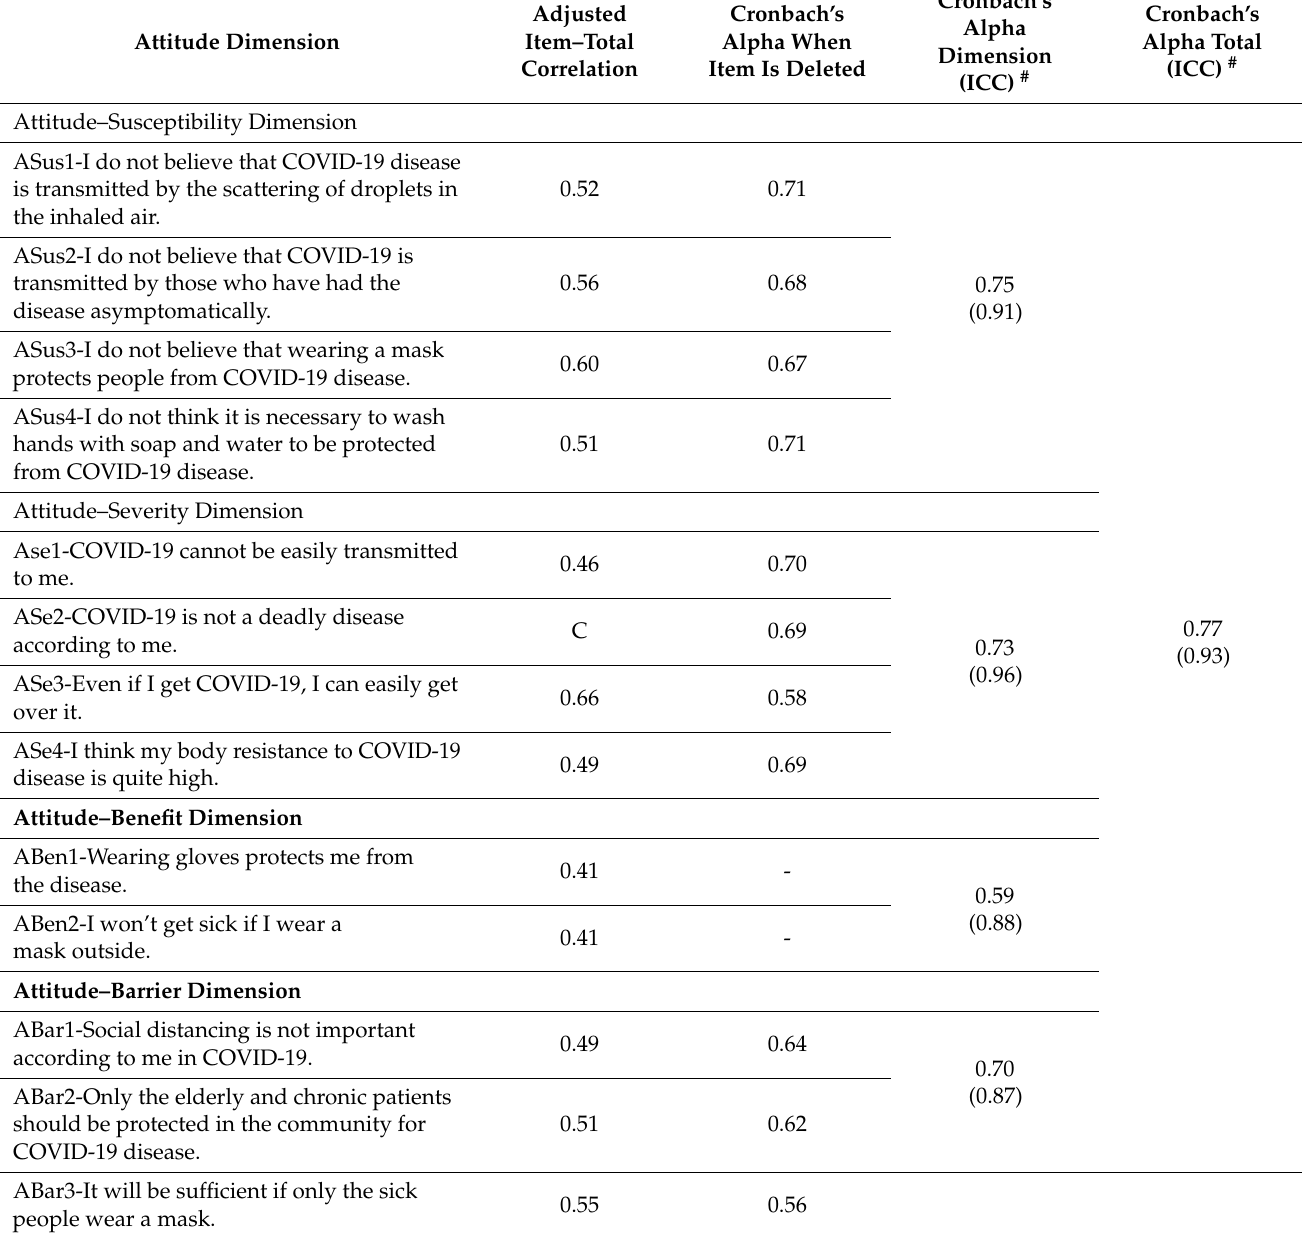
Table 2. Attitude dimension reliability